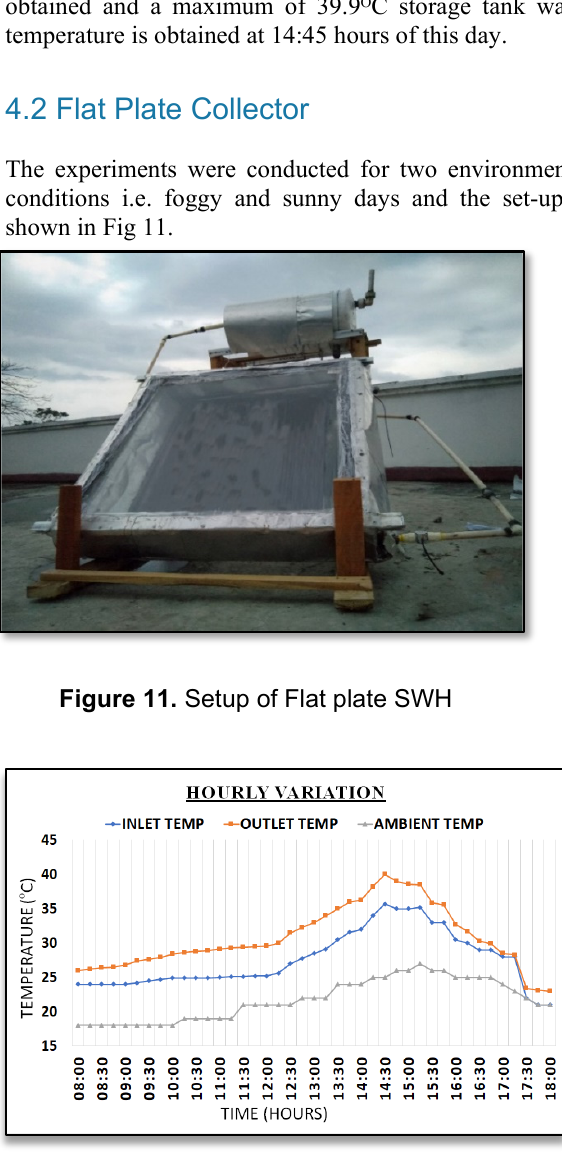
Figure 12. Temp vs Time values on a foggy day